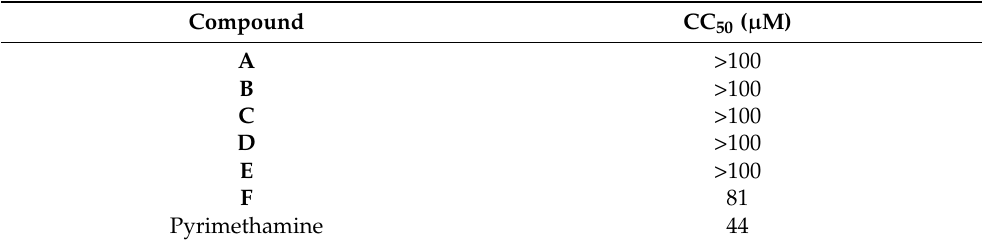
Table 2. In vitro cytotoxicity (CC 50 values) of the natural compounds ( A – F ) from P. selaginellae against human fibroblasts Hs27. Concentration >100 µM indicates no activity in the experimental setup. All experiments were conducted in triplicate.